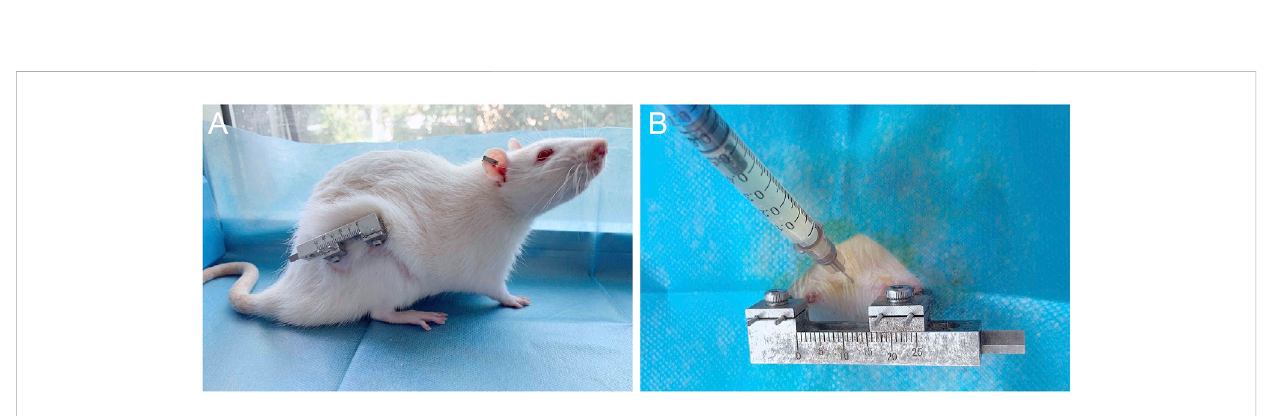
FIGURE 4 Post-operative picture of the rat and schematic diagram of injected cells. (A) Post-operative photos of rats with external fi xation devices. (B) Schematic diagram of injected of cells into the distraction osteogenesis area of rat femur.